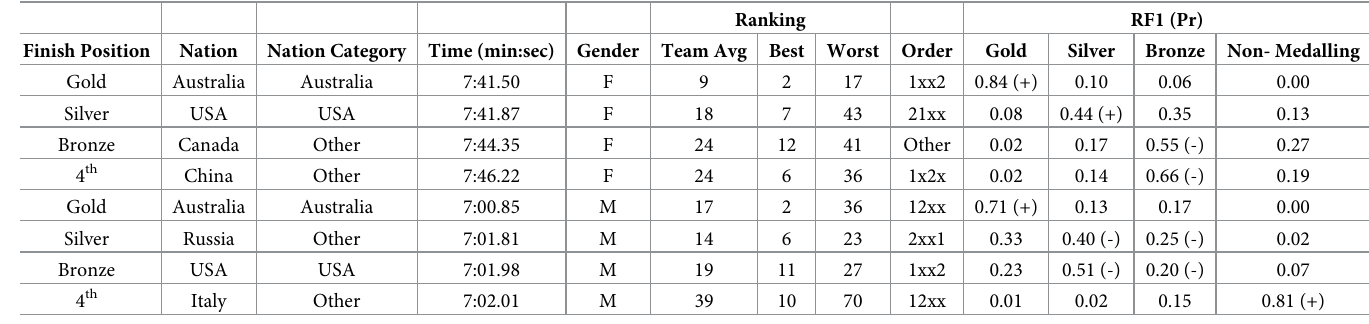
F = female, M = male, Pr = probability.